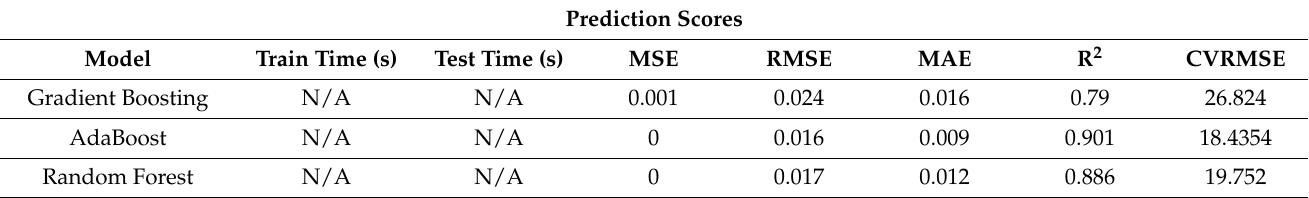
Table 7. Prediction by models.